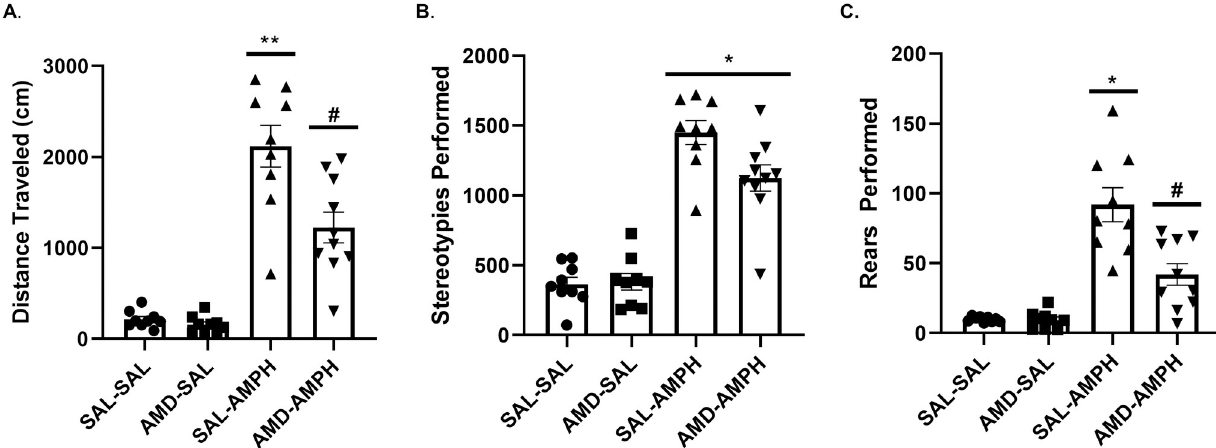
Fig 6. Distance traveled, stereotypies, and rears observed after a 1.0 mg/kg challenge dose of AMPH one week following the four-day AMPH sensitization regimen. Data are represented as Mean (A) distance traveled (B) stereotypies, and (C) rears performed ± SEM. Asterisks ( � ) represent statistically significant differences set at p < 0.05 as compared to AMD-SAL and SAL-SAL groups, double asterisks represent statistically significant differences at p < 0.01, and hash marks (#) represent statistically significant differences between AMD-AMPH and all other groups at p < 0.05.